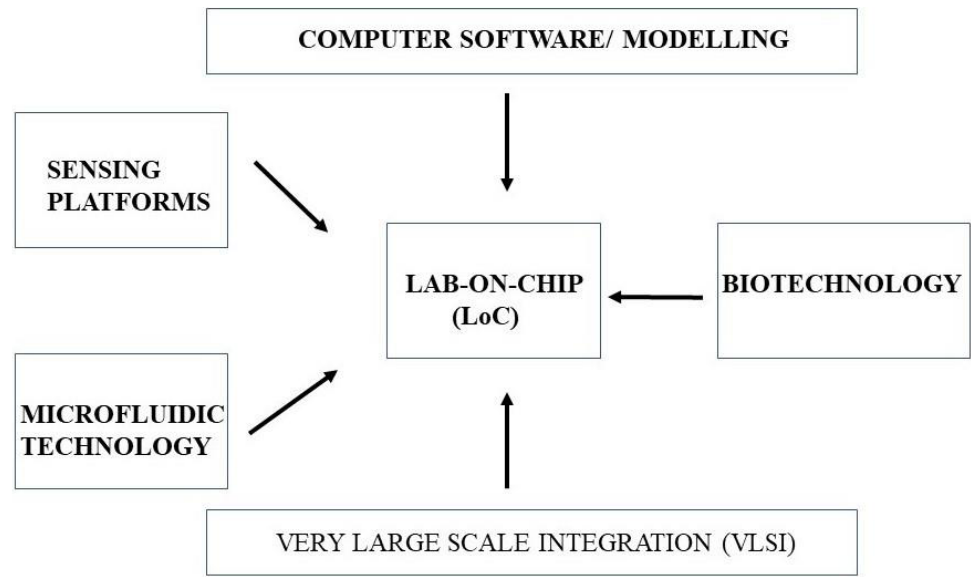
Figure 11. Interdisciplinary field of lab-on-chip technology.